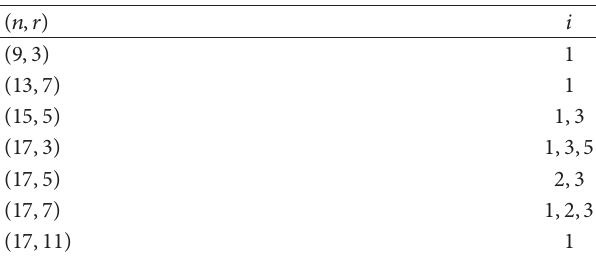
Table 2: The cases for 𝑝(𝑛,𝑟, 𝑖) = 0